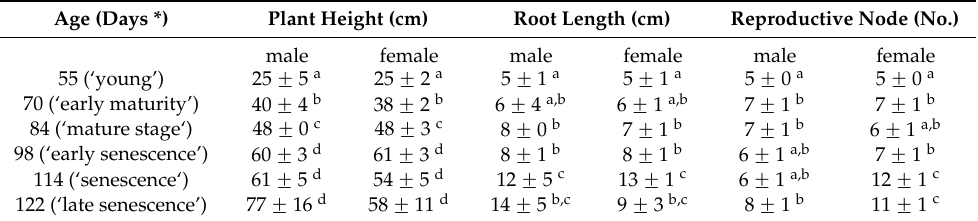
Table 1. Morphological parameters of female and male M. annua plants during development.